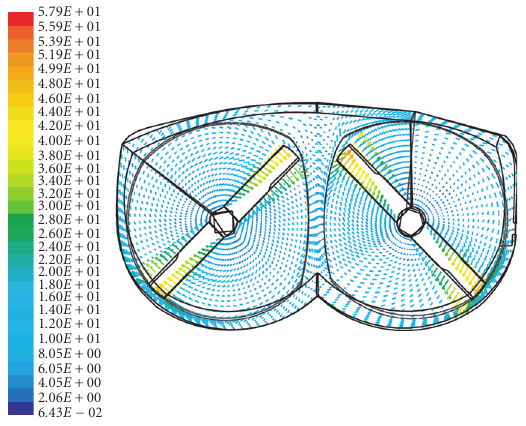
Figure 18: Velocity vectors at the horizontal plane through the blade